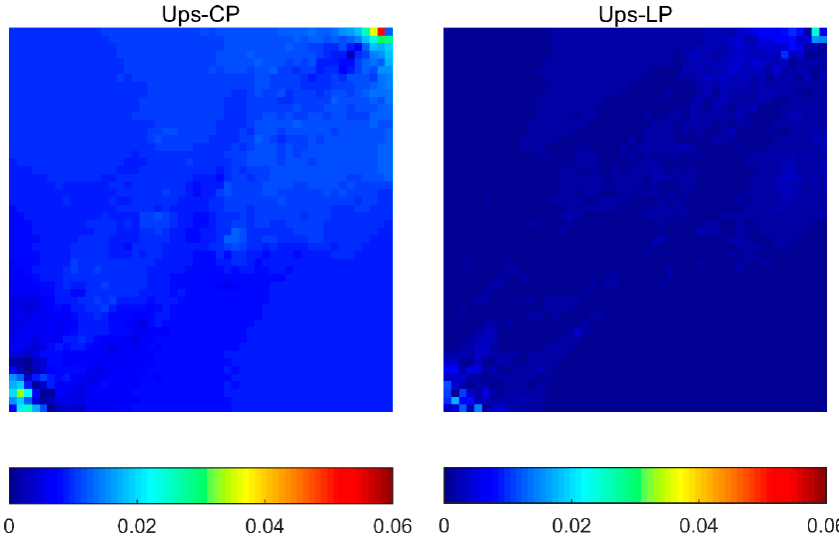
Figure 13. Upscaled permeability tensor represented by ellipses whose semi-axes are scaled by the square root of the principal values. ( Left ) Ups-CP; ( right ) Ups-LP. Energies 2020 , 13 , x FOR PEER REVIEW